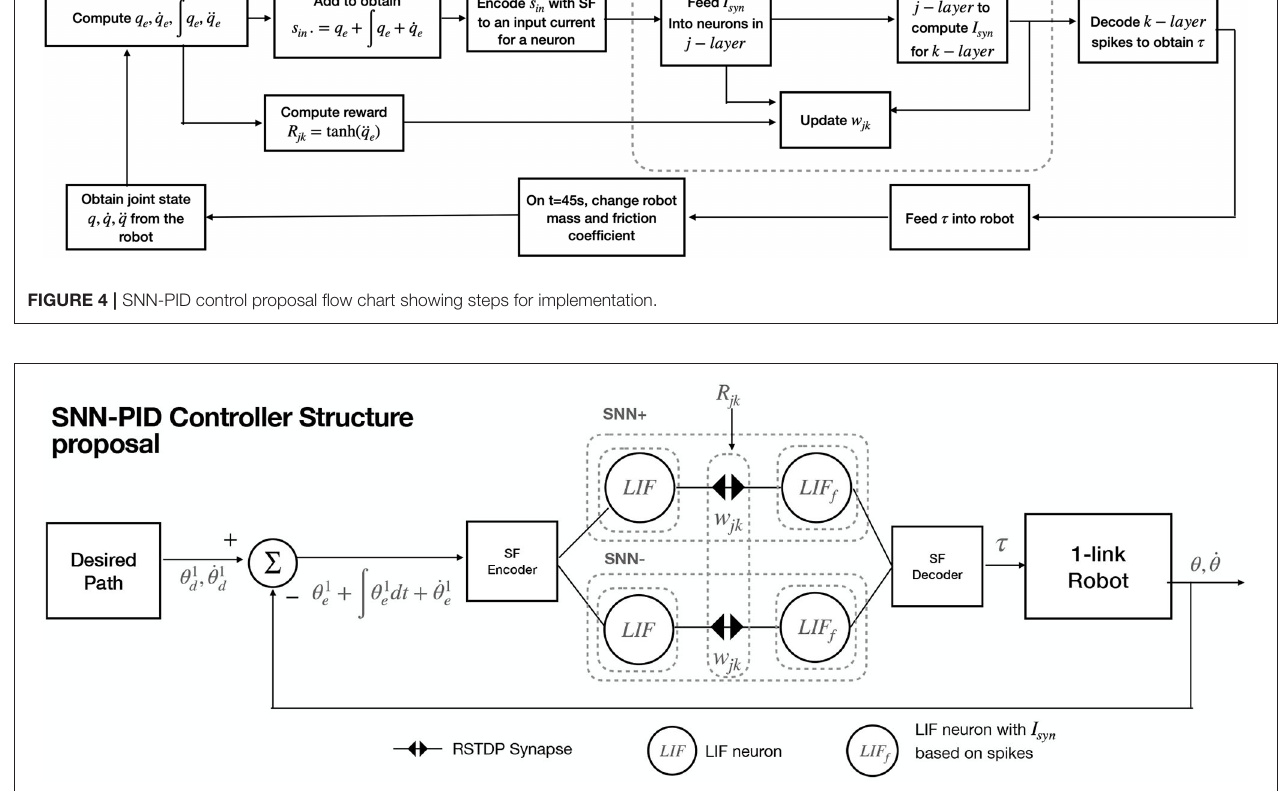
FIGURE 5 | SNN-PID controller neural structure for 1-DOF robot